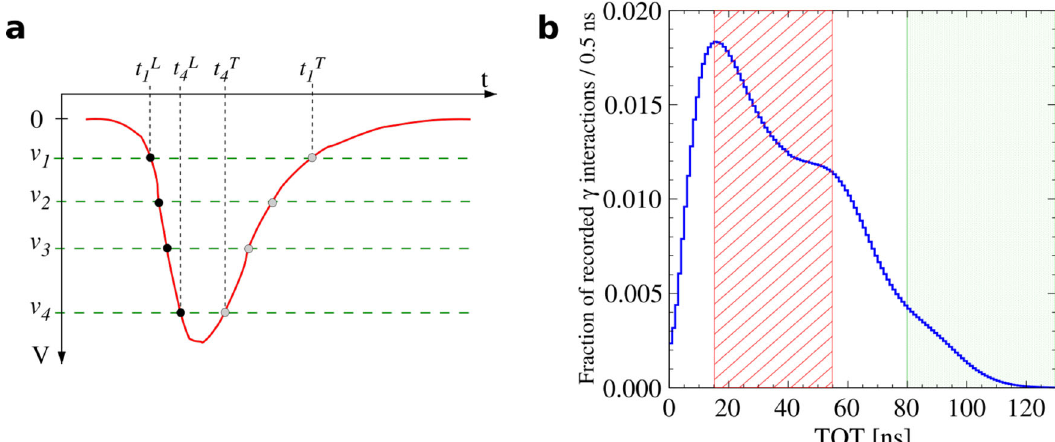
Fig. 2 Measurement of deposited γ energy with time-over-thresholds (TOT). a Photomultiplier electric signals in J-PET sampled at four prede fi ned voltage thresholds ( ν 1 , … , ν 4 ), yielding four timestamps for the leading ( t L i ) and trailing ( t T i ) edges of the signal. The total TOT of a signal is calculated as ∑ 4 t T t L i ¼ 1 ð i (cid:3) i Þ . b Distribution of total TOTs from both photomultiplier signals in J-PET detection modules, used as a measure of photon energy deposited in Compton scattering. The hatched red region is used to identify o-Ps annihilation photon candidates, whereas candidates for prompt photons from 22 Ne* de-excitation are found in the green dotted